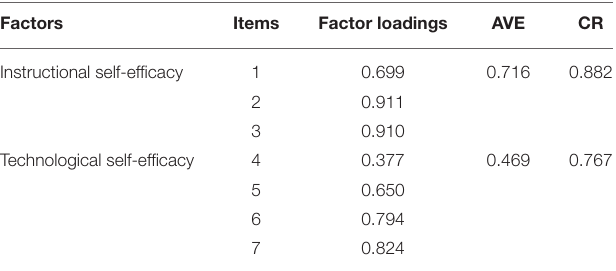
TABLE 3 | Convergent validity of the T-SE